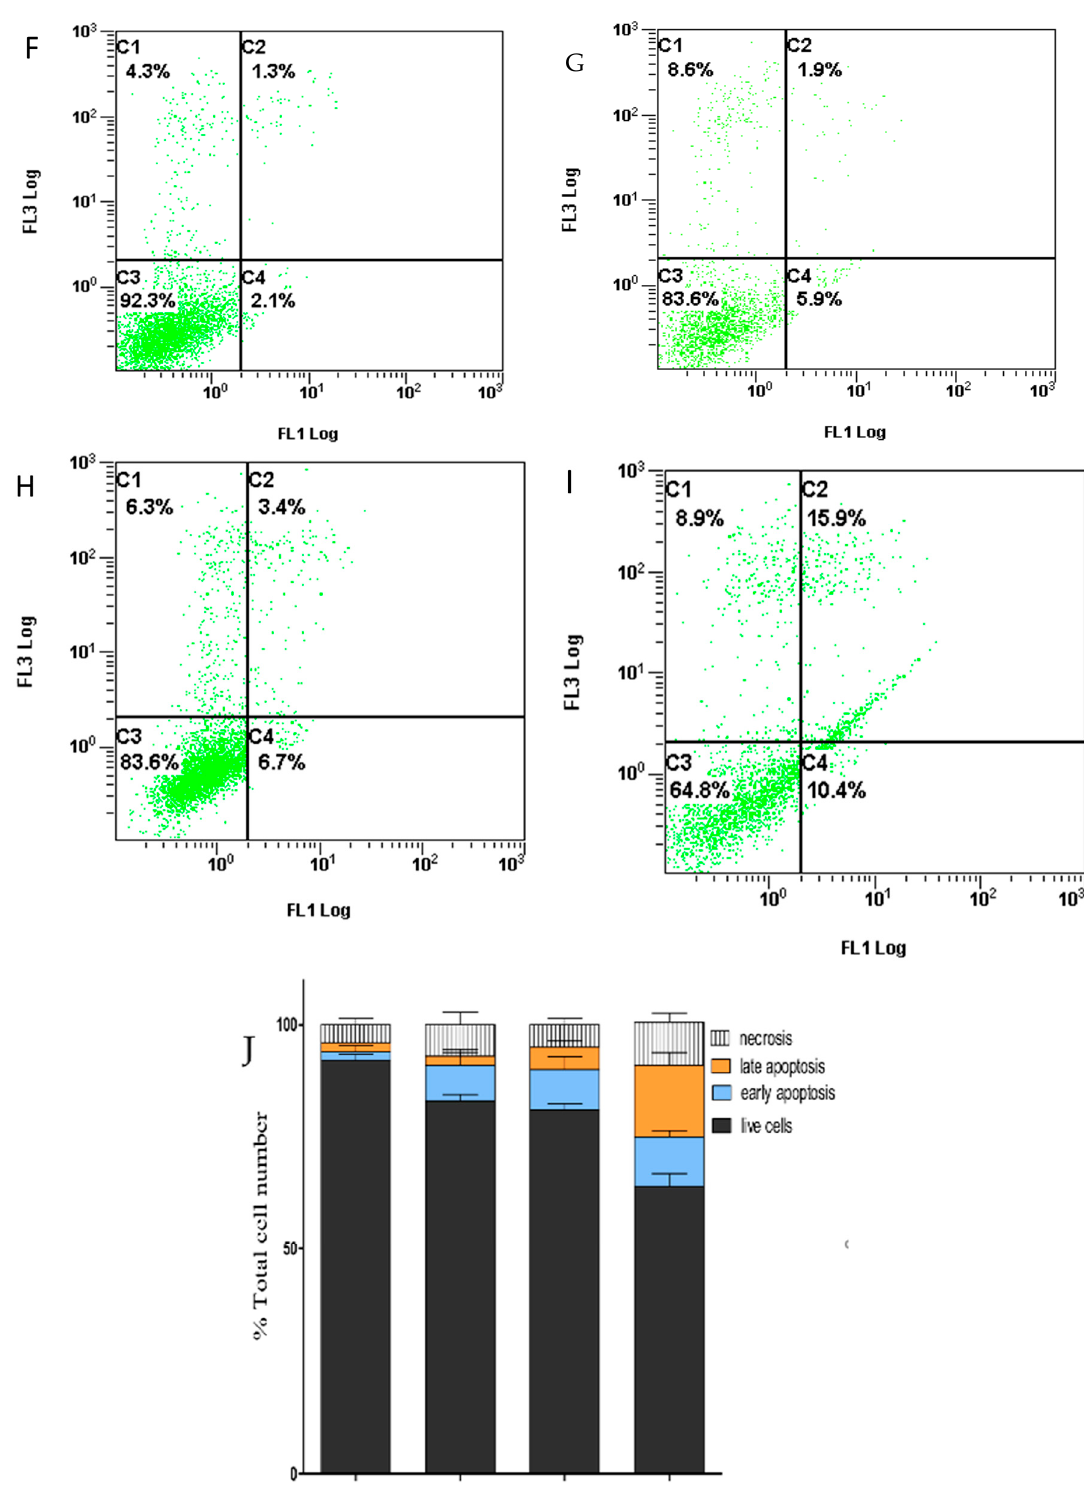
Figure 9. Induction of apoptosis in HT29 and HT29-5FU cells (mean ± SD, n = 3, x3 independent experiments), which were treated (72 h) with either ( A , F ) vehicle, ( B , G ) 5FU (0.25 µ M), ( C , H ) HAA 2020 (3 µ M), or ( D , I ): their combination. Stacked histograms of the different drug treatments in ( E ): HT29 and ( J ): HT29-5FU cells. C1: necrosis, C2: late apoptosis, C3: live cells, C4: early